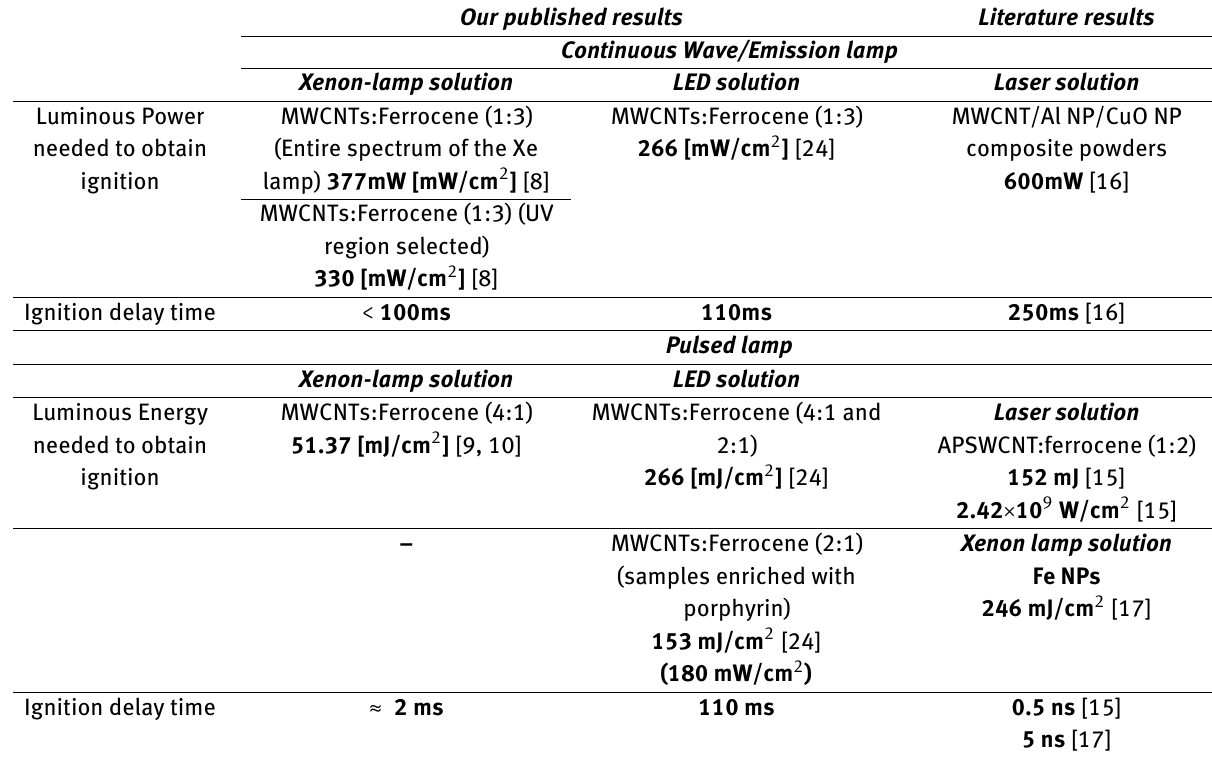
Table 1: Results related to the nano-particles photo-ignition process, by using Xenon lamp, LEDs and laser, obtained by the carried out experimental tests in our research activities and by other research works.